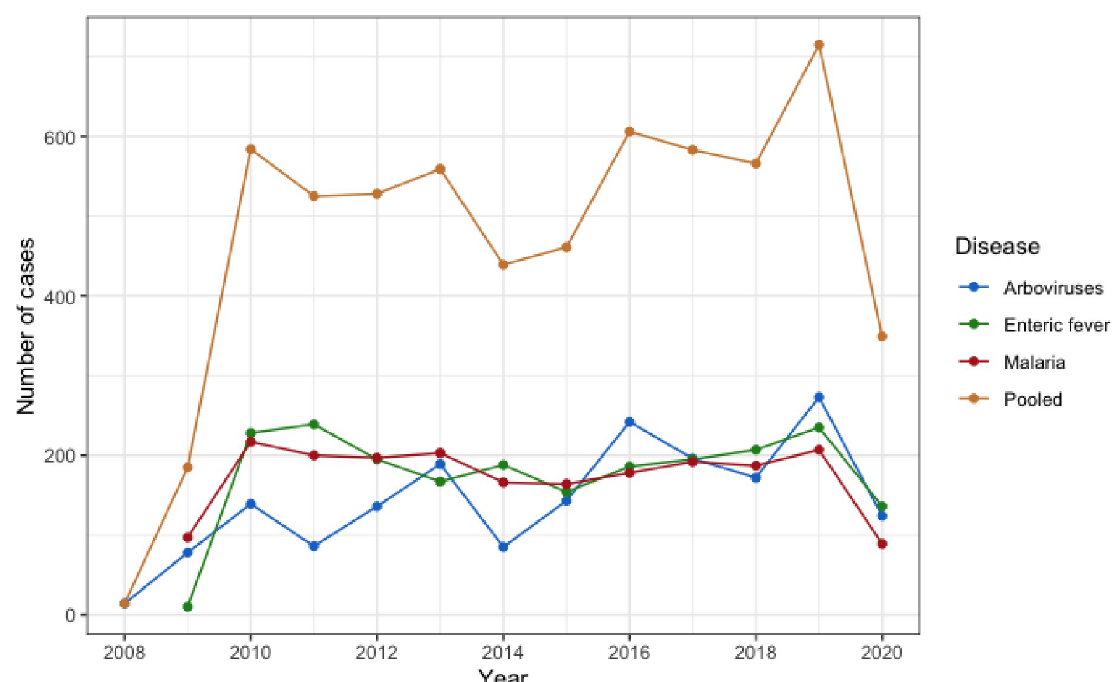
Fig 1. Year-over-year burden of travel-acquired infections in Ontario, Canada. The arbovirus category consists of both dengue and chikungunya.